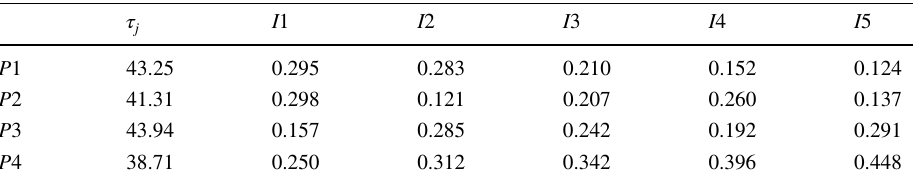
parameters by D-CRMP in case I